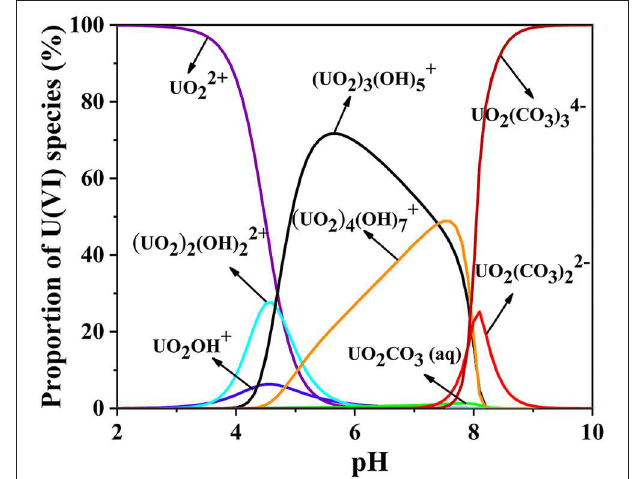
FIGURE 5 | The pH-dependence of various U(VI) species in aqueous solution C U ( VI ) = 100 mg L − 1 (0.038% atm in the presence of CO 2 ).